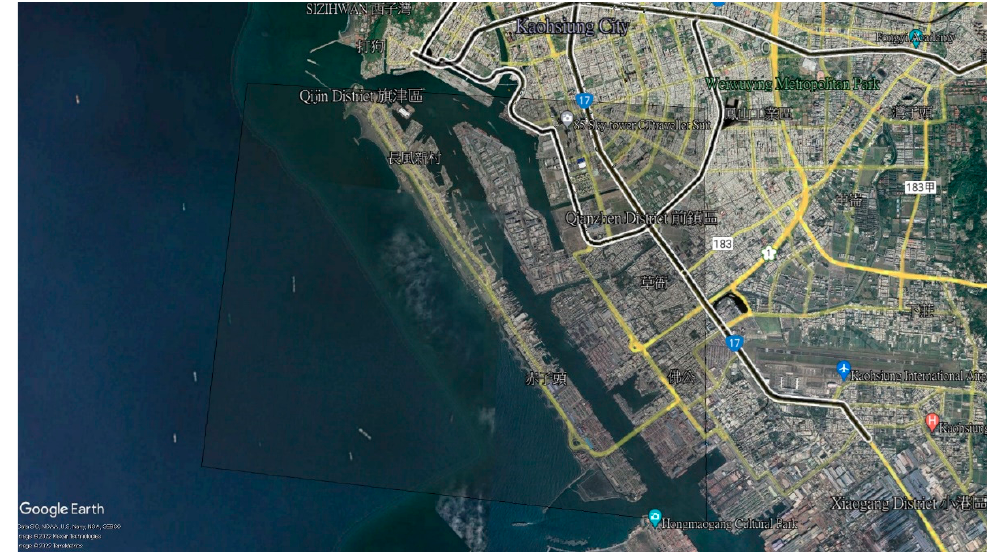
Figure 6. Use Google Earth Pro to select the target coast. Image©2022 Maxar Technologies, Im- age©2022 TerraMetrics.